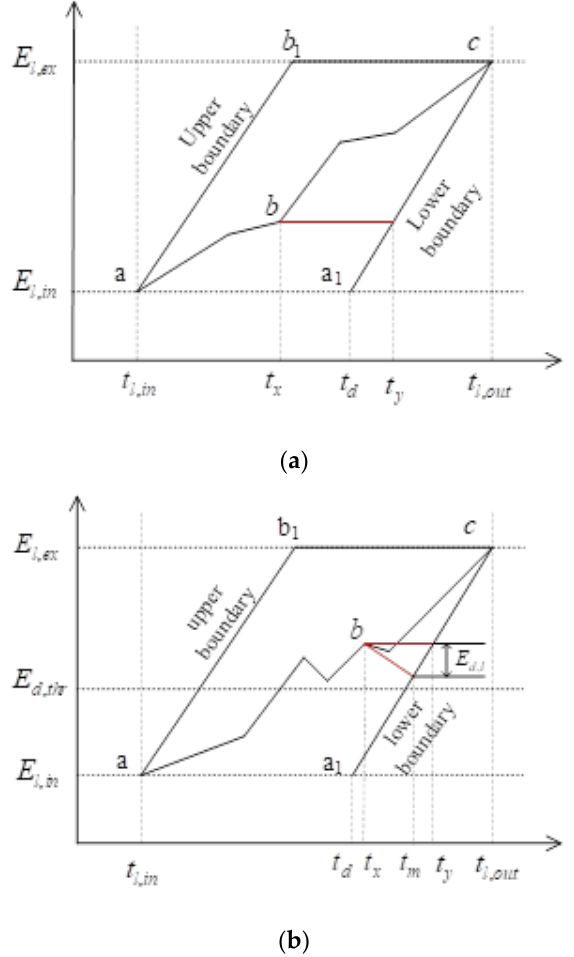
Figure 2. The schedulable capability of Type 2 and Type 3 EVs. ( a ) Adjustable charging EV. ( b ) Flexible charging – discharging EV .